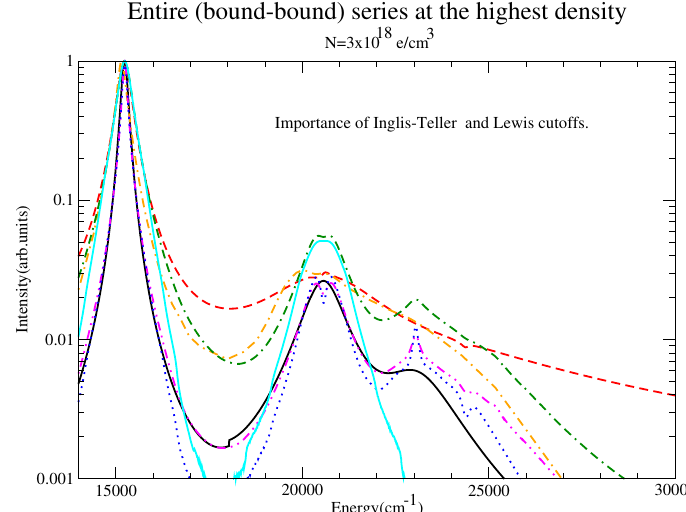
Figure 23. The entire series at the highest density. Shown are QC-FFM (black solid), PPP (red dashed), DWE (orange dash-dotted), CONVST without Inglis-Teller or Lewis cutoff (green dot-double dashed), CONVST with Inglis-Teller and Lewis cutoff (cyan solid), CONVPST without Inglis-Teller or Lewis cutoff (magenta dash-double dotted) and CONVPST with Inglis-Teller and Lewis cutoff (blue dotted). All CONVST/PST runs include strong